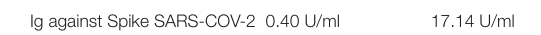
TABLE 2 | Ig anti-Spike SARS COV2 before and after the vaccination (range < 0.80). Before the vaccine After 4 ◦ week the